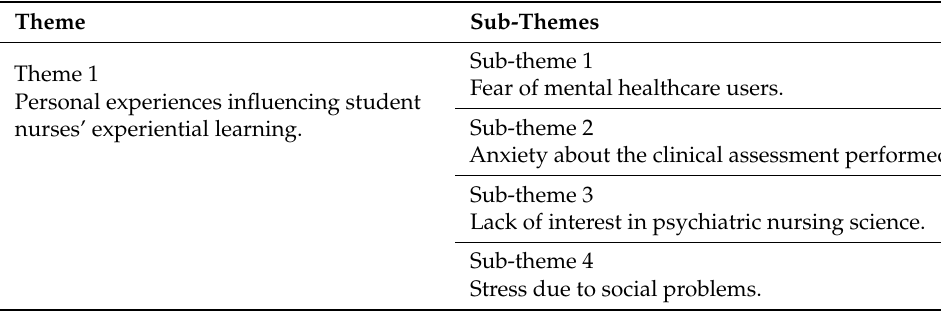
Table 1. Results